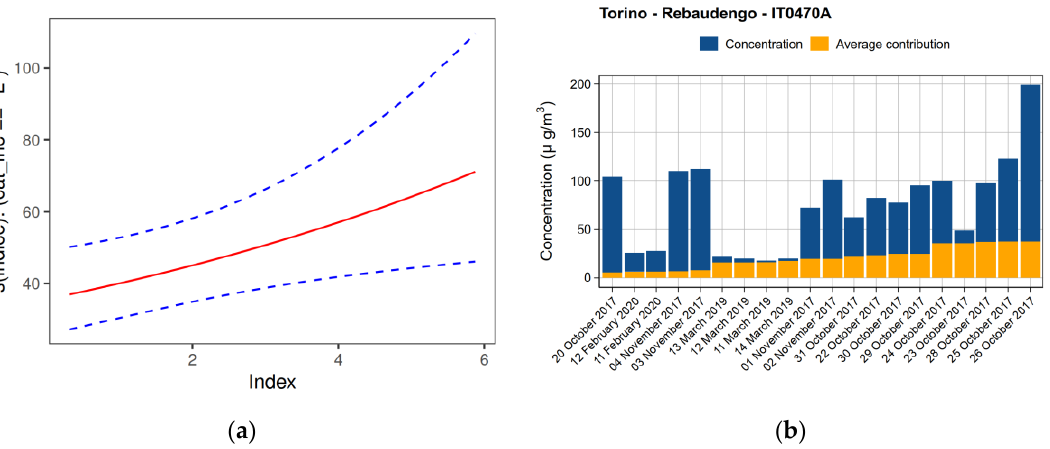
Figure 7. ( a ): Spline functions for categorial index variable selected in the PM 10 model developed for the air quality monitoring station (red line represents the contribution to PM 10 levels with the respect to index values, blue dotted lines in the graphs represent 95% confidence interval); ( b ): Estimated model contribution of wildfires to daily average concentrations of PM 10 concentrations observed in the air quality monitoring station.